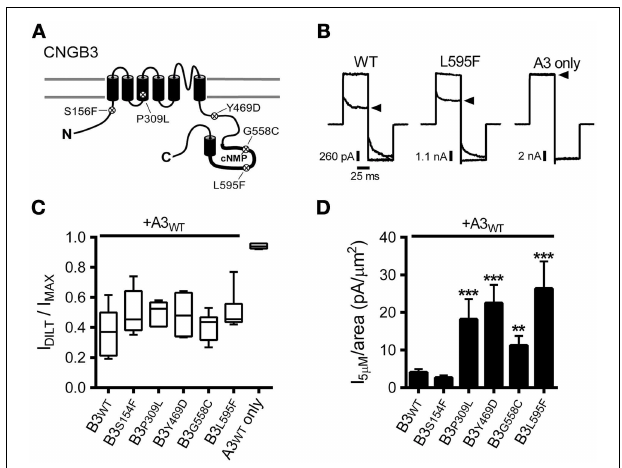
FIGURE 1 | CNGB3 disease-associated mutations impart a gain-of-function phenotype in heteromeric CNG channels. (A) Diagram showing CNGB3 subunit topology with approximate locations of disease associated mutations examined in this paper. (B) Representative current traces from inside-out patches excised from X enopus oocytes expressing heteromeric human A3+B3 channels activated by a saturating concentration (1mM) of cGMP in the presence (arrowhead) or absence of 25 µ M L-cis-diltiazem. Current traces were elicited using voltage steps from a holding potential of 0mV, to + 80mV, − 80mV, and then returning to 0mV. (C) Box plots summarizing the sensitivity to diltiazem block of channels containing disease-associated mutations compared to wild type A3 + B3 heteromeric (WT) and CNGA3-only homomeric channels (A3). Data are expressed as the ratio of the 1mM cGMP current amplitude at + 80mV in the presence and absence of diltiazem (as in B ). Boxes represent 25th–75th percentiles, lines show the median, and whiskers represent the 5th–95th percentiles. (D) Summary of current densities at 5 µ M cGMP for CNGB3 disease-associated mutations. Current-density estimates are based on cGMP dose-response data and estimates of patch area using patch electrode resistance (Sakmann and Neher, 1995 ). Four of the five mutations examined had an increase in the 5 µ M current density compared to wild type A3 + B3 channels ( p < 0 . 001 , single-factor ANOVA, n = 6 – 23 ; Holm’s t -test, ** p < 0 . 01 , *** p < 0 . 001